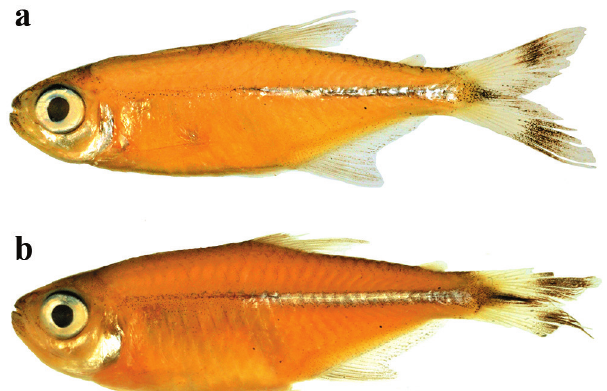
Fig. 6. Coloration pattern in alcohol-preserved specimens of Moenkhausia bonita . a. MLP 11244, 31.9 mm SL, Uruguay basin; b. MLP 11241, 33.1 mm SL, Paraná